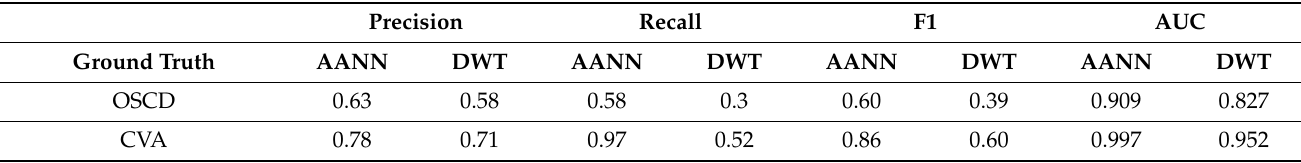
Table 2. Results for test image 1.